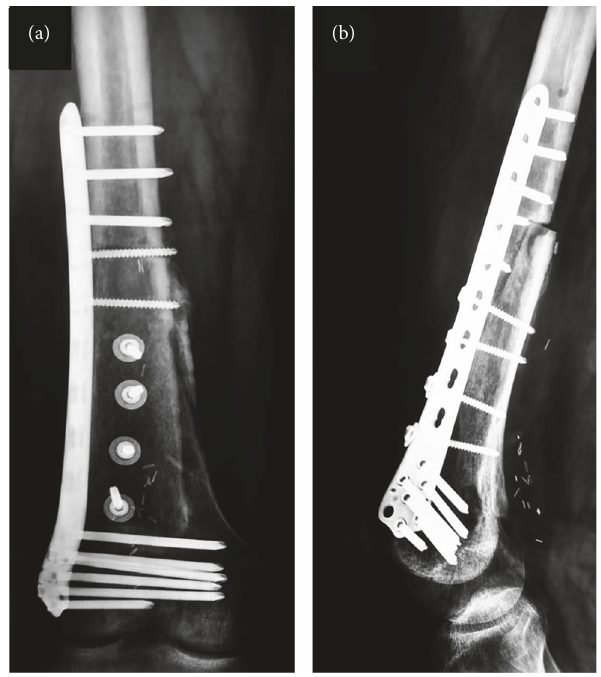
Figure 7: Anteroposterior (a) and lateral radiographs (b) nine months postoperatively showing incorporation of the allograft at the distal part. However, the proximal part of the allograft shows partial